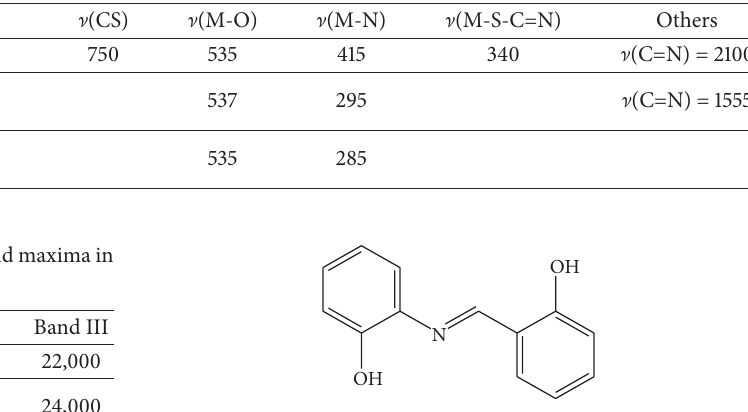
Figure 1: (2-Hydroxy-benzylidene)-(2-hydroxy-phenyl)-amine (SB-1). Yield: 3.0 g (78%). Anal. Calc. (%): C, 73.2; H, 5.2; N,